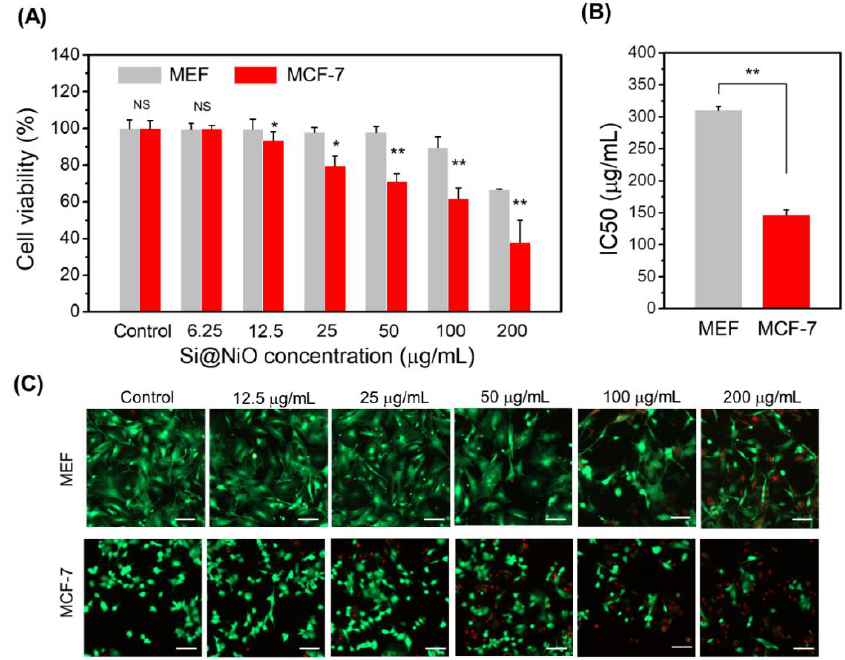
Figure 6. Cytotoxicity and anticancer activity of Si@NiO nanoflowers. ( A ) Cytotoxicity of Si@NiO toward the MEF and MCF-7 cells after 24 h of incubation. ( B ) IC 50 values of Si@NiO in the MEF and MCF-7 cells. ( C ) Live/dead staining images of MEFs and MCF-7 after incubation with various concentrations of Si@NiO for 24 h. Positive control: cells cultured in the absence of Si@NiO. NS: not significant, * p < 0.05 and ** p < 0.01. Scale bar: 100 μm.